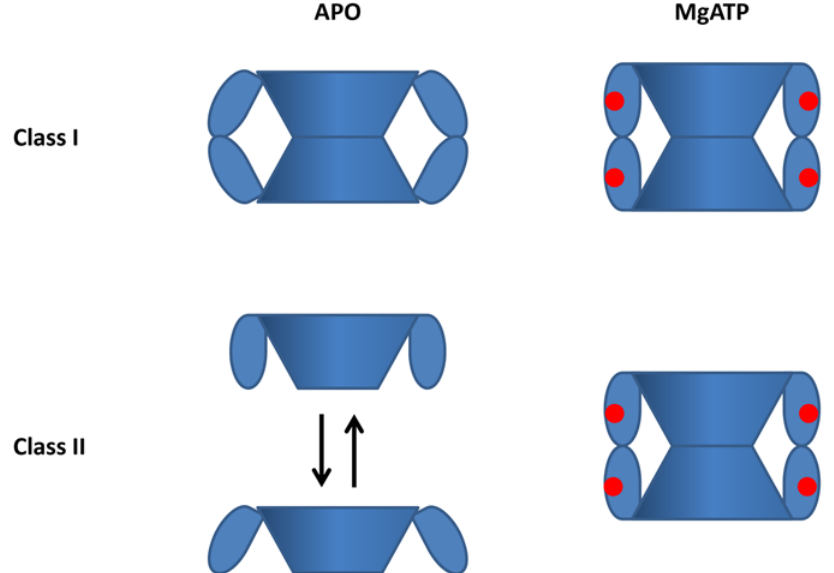
Fig 7. Proposed model of the modulation of the quaternary structure of class I and class II IMPDHs in the absence (APO) or in the presence of MgATP. For each tetramer, the core domain is represented as a cone and the CBS modules are on the side. MgATP are shown as red circles. Class I IMPDHs adopt an octameric architecture where the CBS modules of two tetramers interplay together in. MgATP induces a global shape rearrangement without disturbing the degree of oligomerization. Class II IMPDHs are tetrameric in the apo state. Different conformations of the tetramers would coexist and the addition of MgATP would trigger the equilibrium towards tetrameric species, which would dimerize into